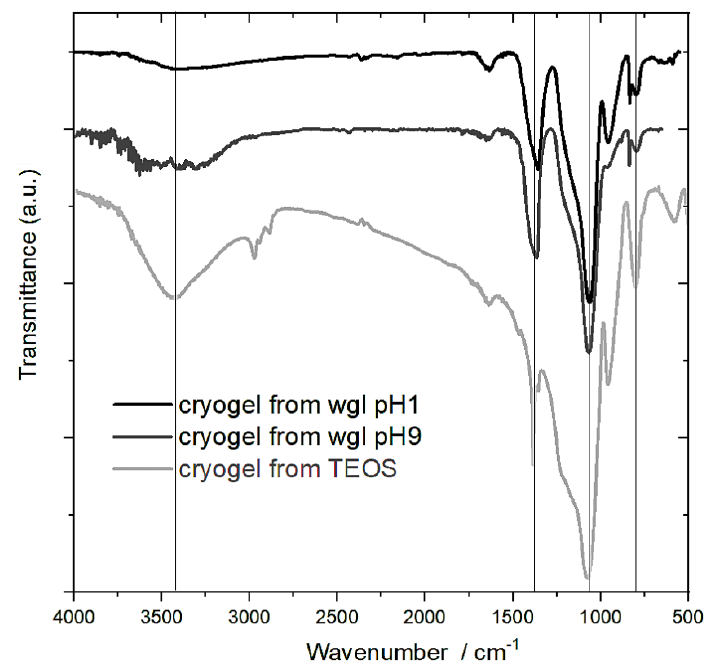
Figure 5. FTIR spectra of cryogels prepared from water glass in medium of pH 1 and pH 9 and from TEOS catalysed by HNO 3